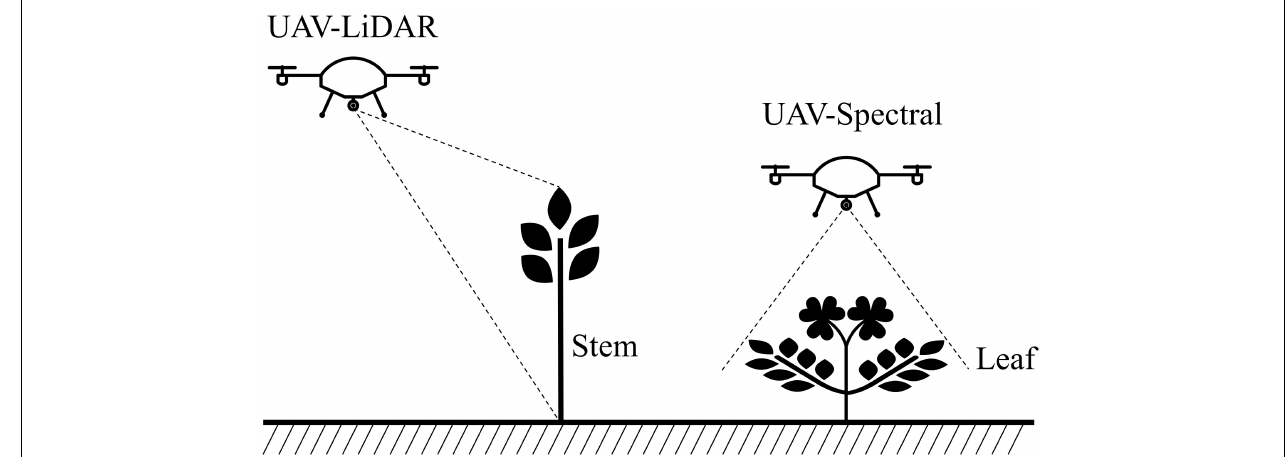
FIGURE 3 | A schematic illustration of the difference between LiDAR and spectral